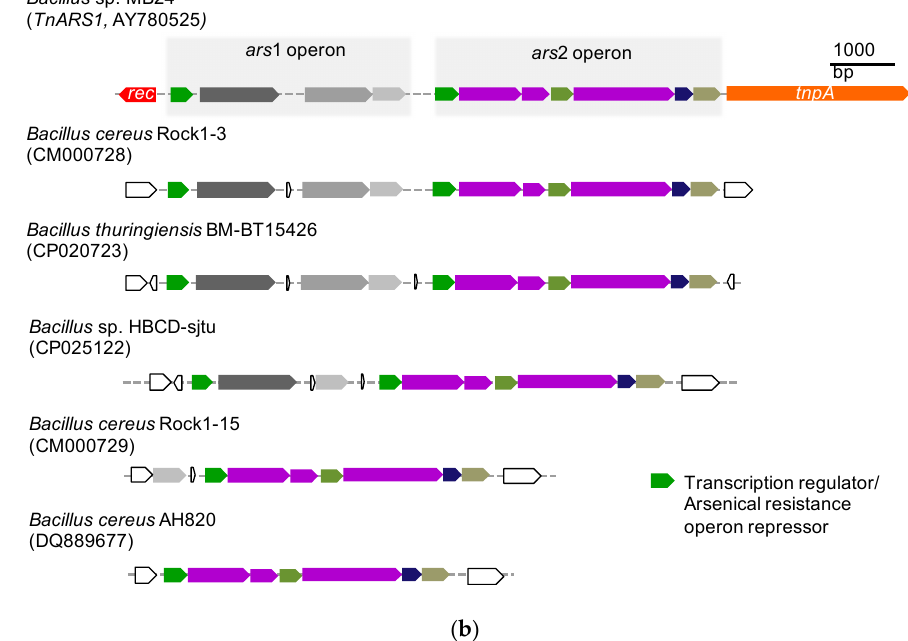
Figure 4. Selected blasting results of ( a ) Tn 5084 -like and ( b ) Tn ARS 1-like transposons among bacteria by using the MultiGeneBlast analysis. The databases are the BTC database (Genbank: bacterial division, December 2018) and the whole genome sequences of the Bacillus database (NCBI, August 2019). The threshold of gene identity is 30% and the gene clusters. tnpA : transposase gene; tnpR : resolvase gene; B3 : organomercurial lyase gene merB3 ; R : mercury-responsive transcriptional regulator gene merR ; E : mercury resistance gene merE ; T : mercury transpor gene merT ; P : metal binding protein gene merP ; A : Mercuric reductase gene merA ; R2 : mercury-responsive transcriptional regulator gene merR2 ; B2 : organomercurial lyase gene merB2 ; B1 : organomercurial lyase gene merB1 . GenBank accession numbers are listed following bacterial strains. Tn MERI1 : LC152290; Tn 5084 : AB066362.1; Bacillus cereus #17: JYFW01000036; B. cereus PE8-121b: LRPI01000016.1.